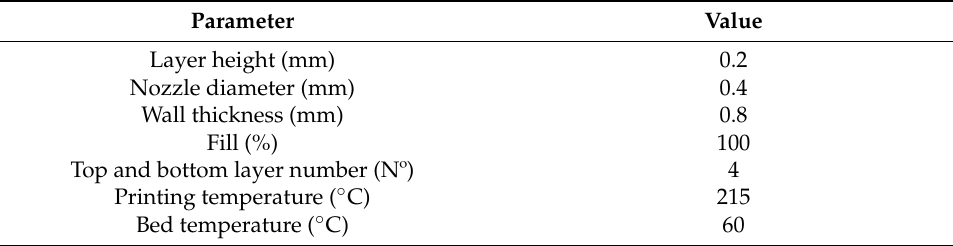
Figure 1. Industrial manufacturing process at Smart Materials 3D company ( a ) Compounder mate- rial mixing by melting; ( b ) Composite filament extrusion; ( c ) 3D printing of parts. Table 1. 3D-Printing process settings for Artillery GENIUS